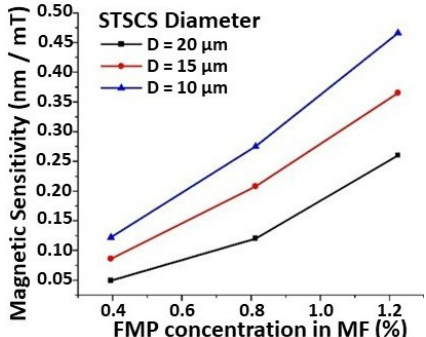
Figure 5. Magnetic sensitivity comparison for STSCS optical fibre sensors with 10, 15, and 20 μm diameters surrounded by 0.39, 0.81, and 1.22% FMPs in the MF.